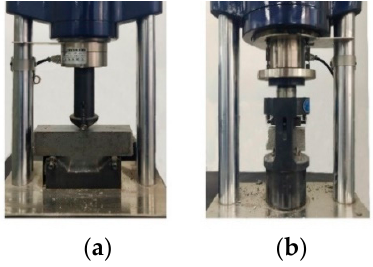
Figure 2. Detailed wet-sieved process.